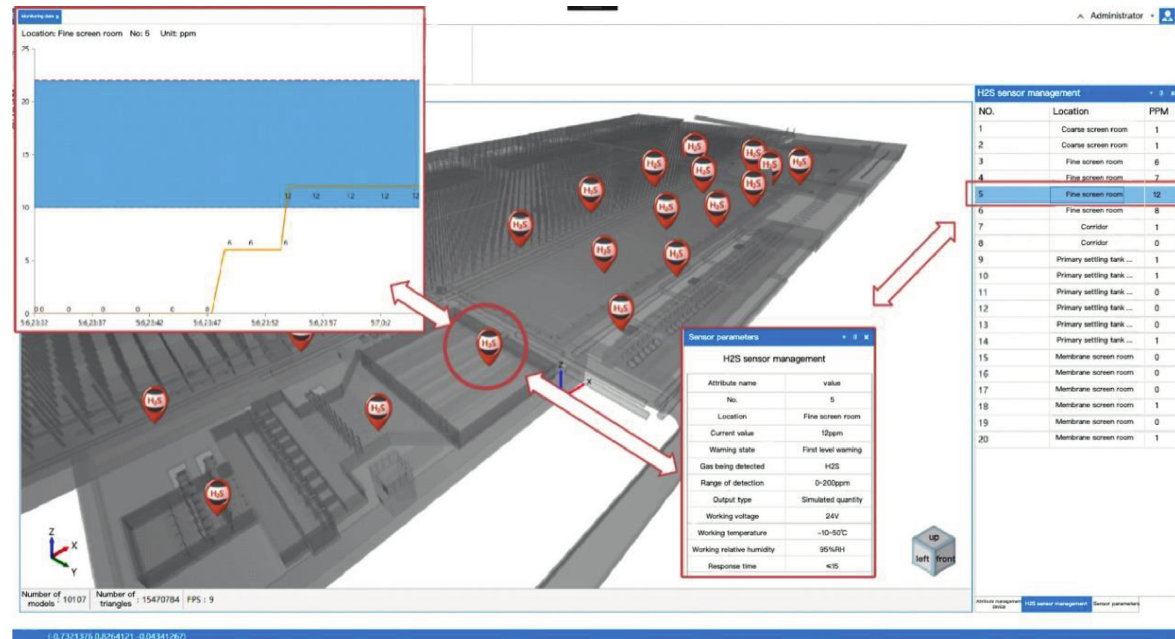
Figure 7: Querying the H